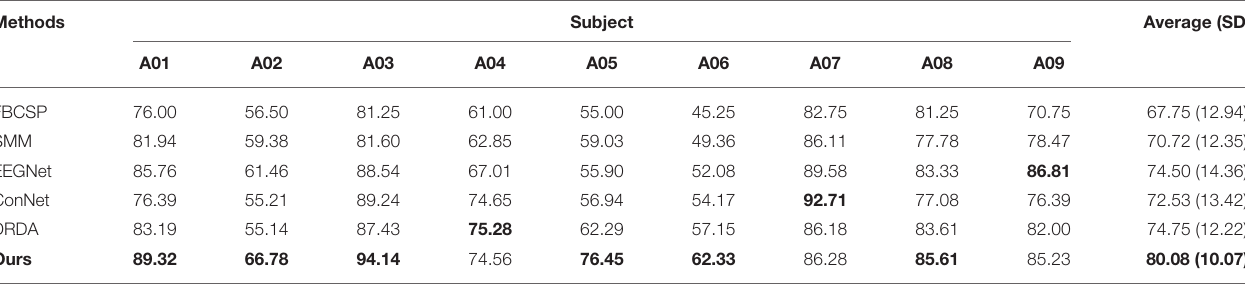
TABLE 3 | Classification accuracies (%) obtained with the dataset BCI competition IV-2a. Methods